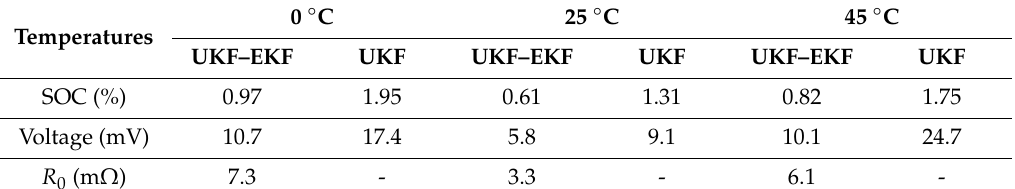
Table 3. The estimation of RMSEs for the UKF–EKF and UKF under BJDST. 0 ◦ Temperatures